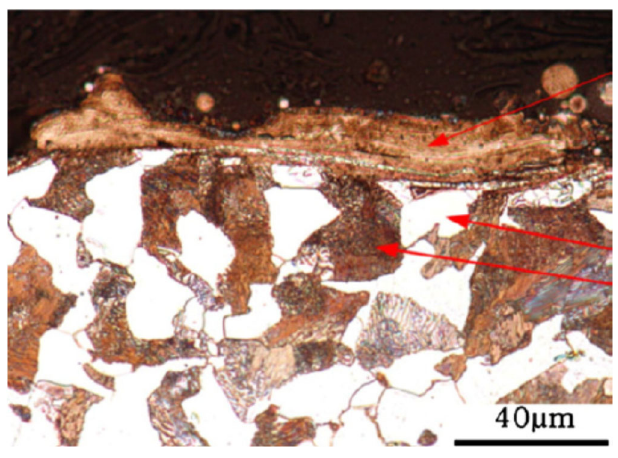
Figure 4 . Microstructure presents martensite formation at the surface during LSP of medium carbon steel [77].